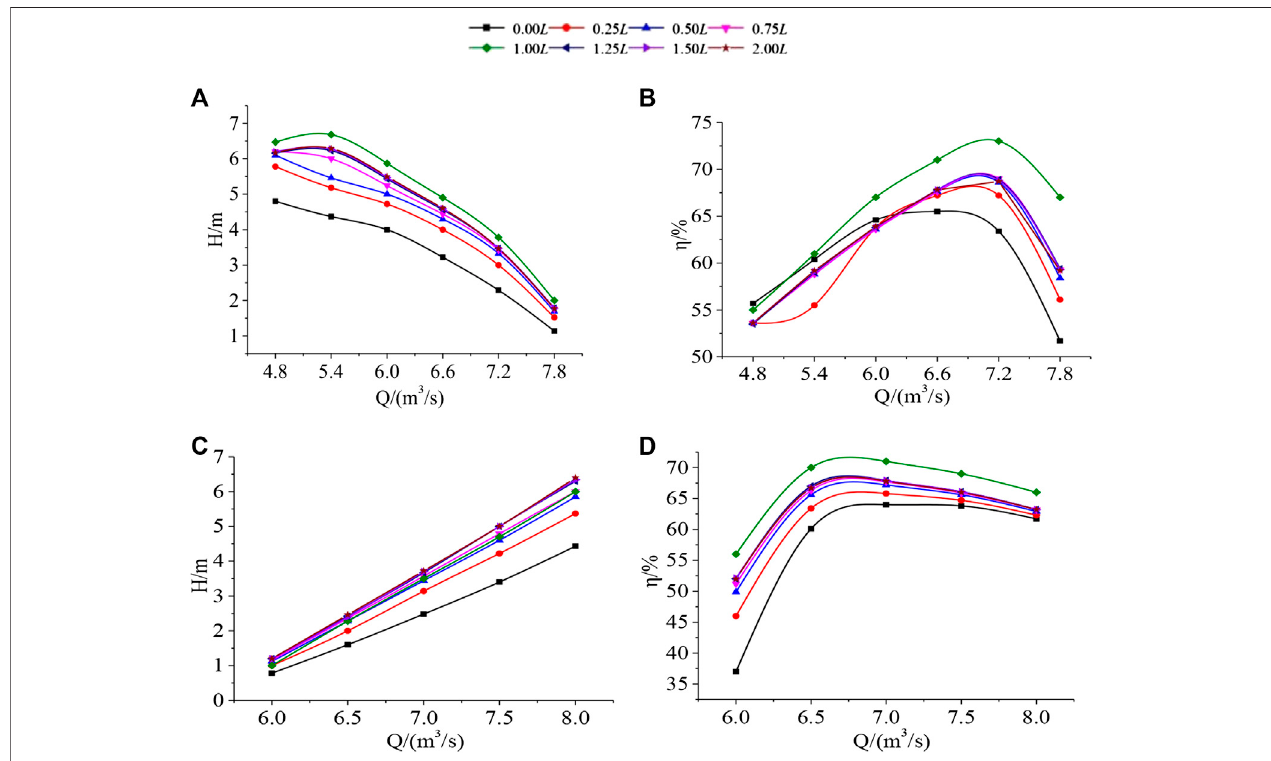
FIGURE9| Performancecurvesofpumpsandturbineswithdifferentinter-stageclearances. (A) thepumphead. (B) thepumpef fi ciency. (C) theheadcurvesofthe turbine. (D) the ef fi ciency curves of the turbine.